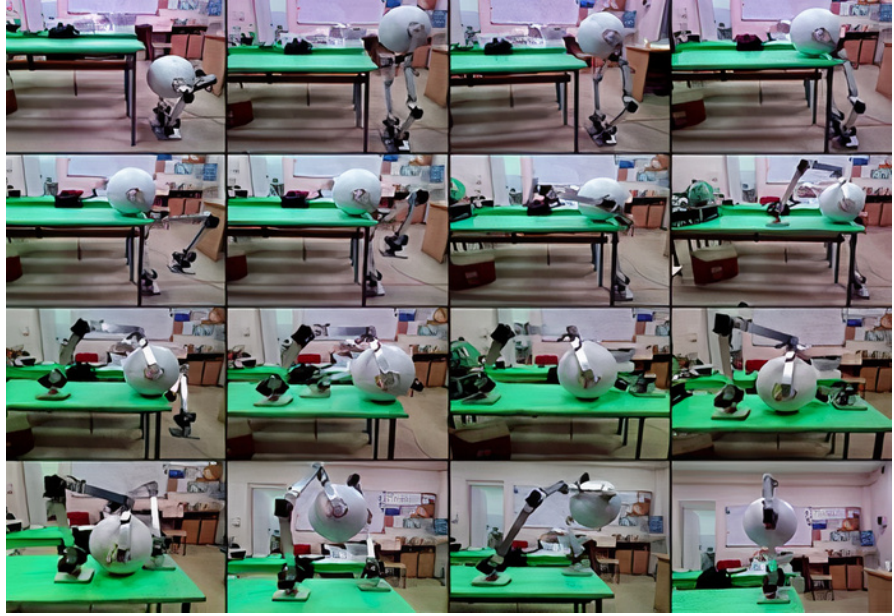
Figure 7. AnyWalker climbing an